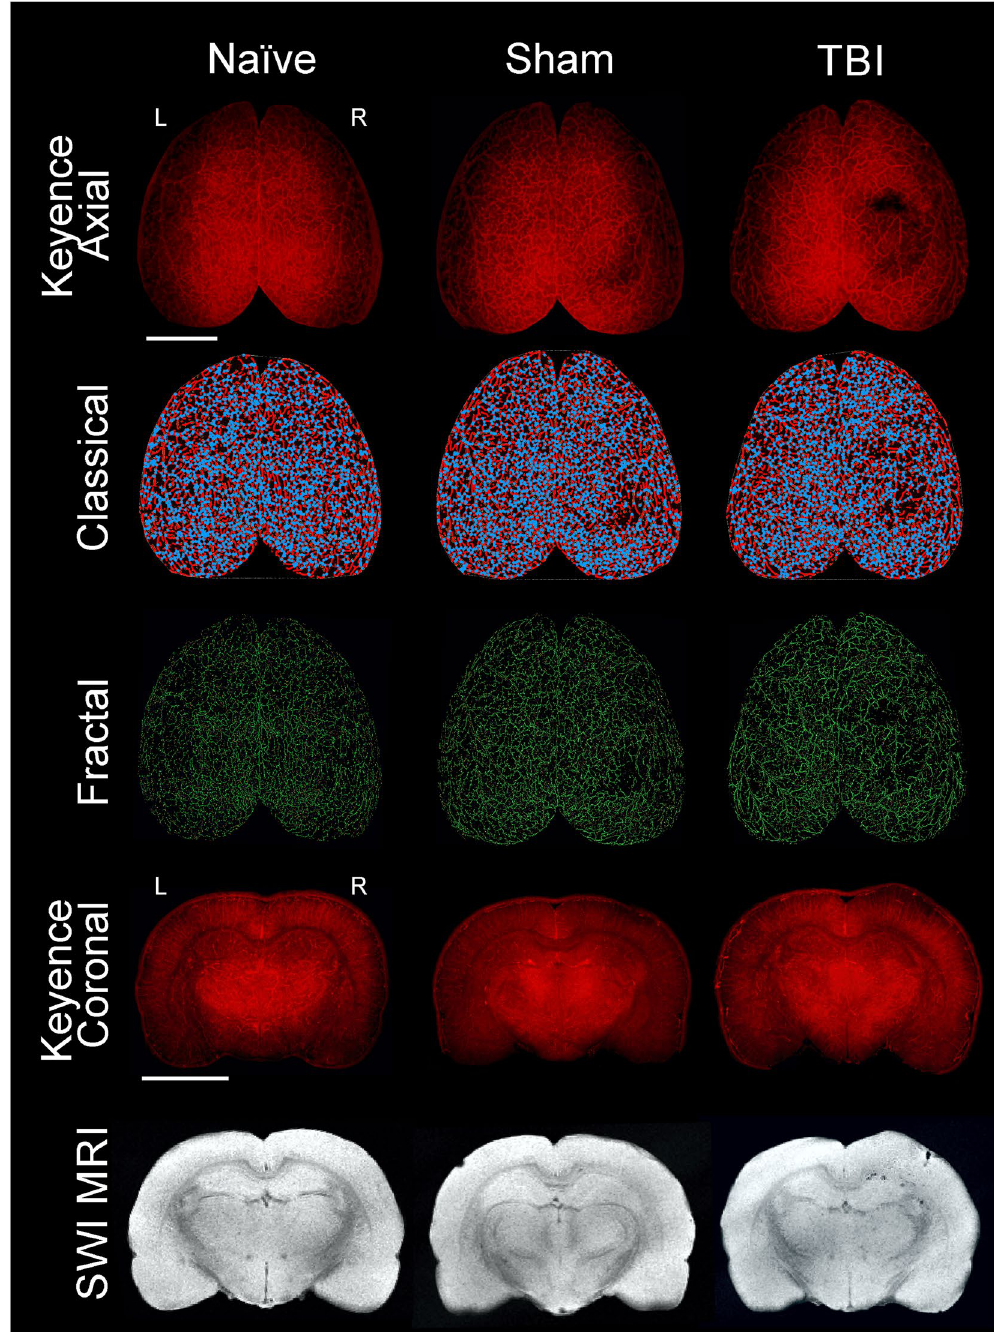
Figure 1. Traumatic brain injury results in vascular loss. The top three rows display representative axial images from wide field epifluorescent vessel painting, classical vascular analysis (AngioTool), and fractal analysis (FracLac) maps. The bottom two rows illustrate coronal images of vessel painted brain tissue and complimentary susceptibility weighted magnetic resonance imaging (SWI MRI) to monitor the extent of extravascular bleeding. Each column is representative for naïve, sham, and TBI brains. The images from the naïve animal demonstrate a diffuse and uniform pattern of vessels without vascular disruptions. The sham animal exhibits slight vascular alterations due to the craniotomy. In contrast, the TBI animal has a clear and overt a region of vessel disruption at the site of injury on both the axial and coronal vessel painted microscopic images. These disruptions to the vascular system after TBI are also visible on the classical vascular analysis maps and on the fractal analysis